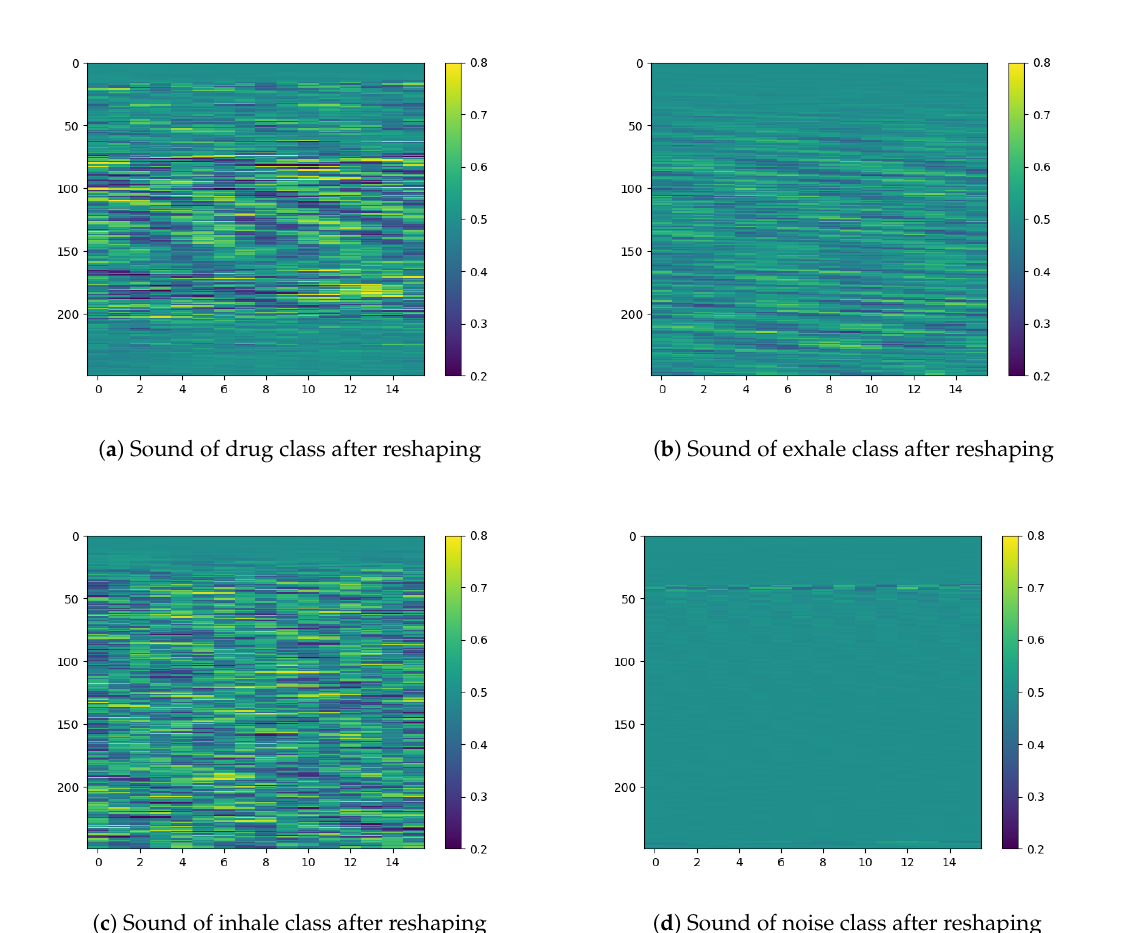
Figure 5. Visualization of the segmented audio files for each respiratory phase after the reshaping